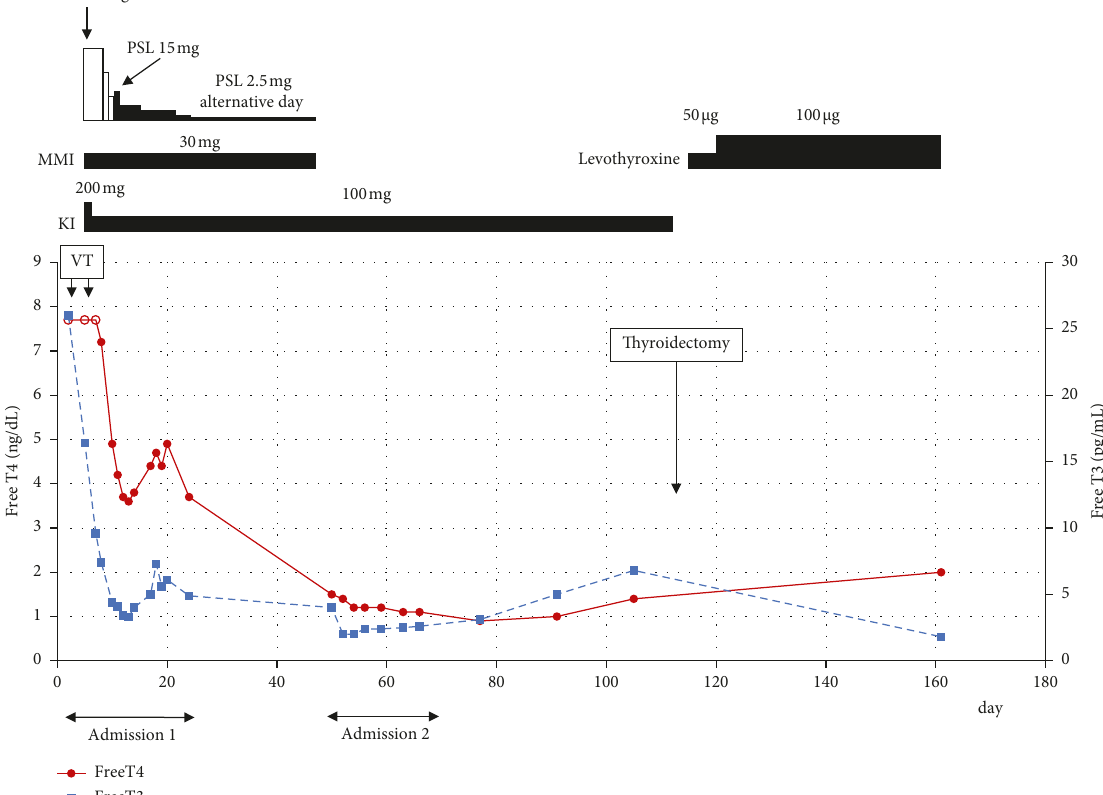
Figure 3: Total clinical course of the patient. Open circles indicate the value of free T4 mean more than 7.7ng/dL. HCZ: hydrocortisone; PSL: prednisolone; MMI: methimazole; KI: potassium iodide; VT: ventricular tachycardia; T3: triiodothyronine; and T4: